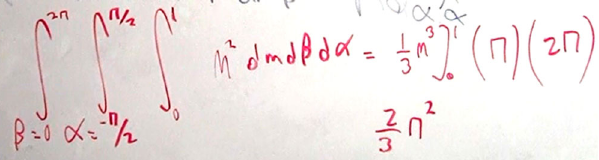
FIG. 7. Elliot and Frank check their incorrect differential volume element by